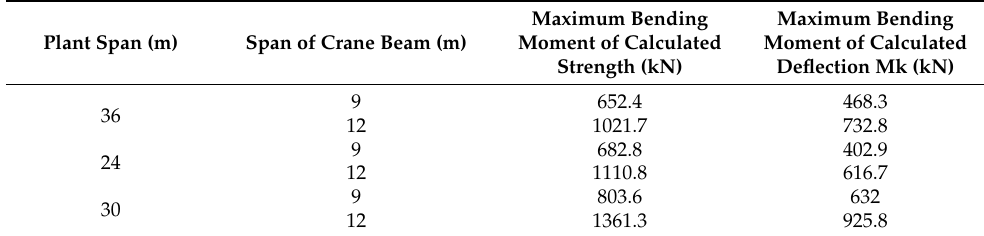
Table 3. Most unfavorable load of crane